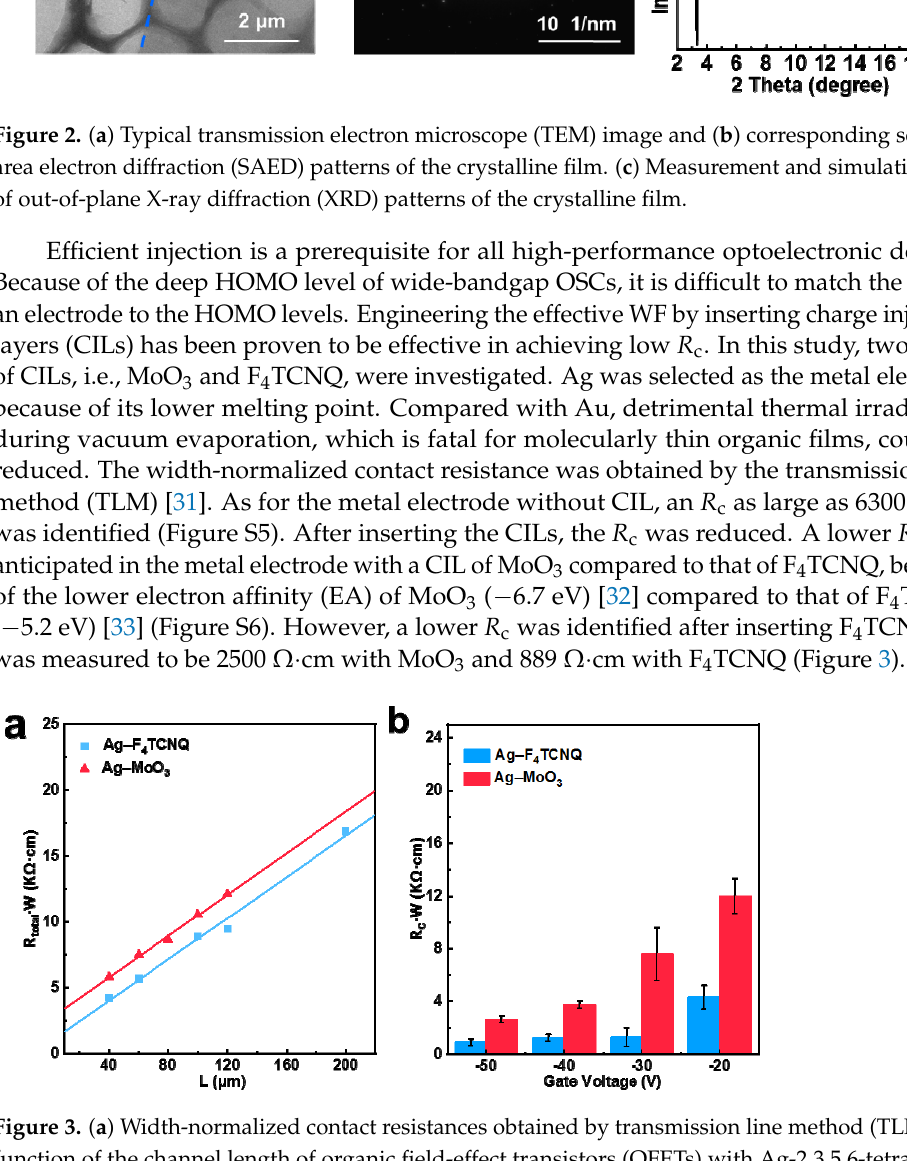
Figure 3. ( a ) Width-normalized contact resistances obtained by transmission line method (TLM) as a function of the channel length of organic field-effect transistors (OFETs) with Ag-2,3,5,6-tetrafluoro-7,7,8,8-tetracyanoquinodimethane (Ag–F 4 TCNQ) and Ag–MoO 3 electrodes under a gate voltage of − 50 V. ( b ) Width-normalized contact resistances of OFETs with Ag–F 4 TCNQ and Ag–MoO 3 electrodes under different gate voltages.